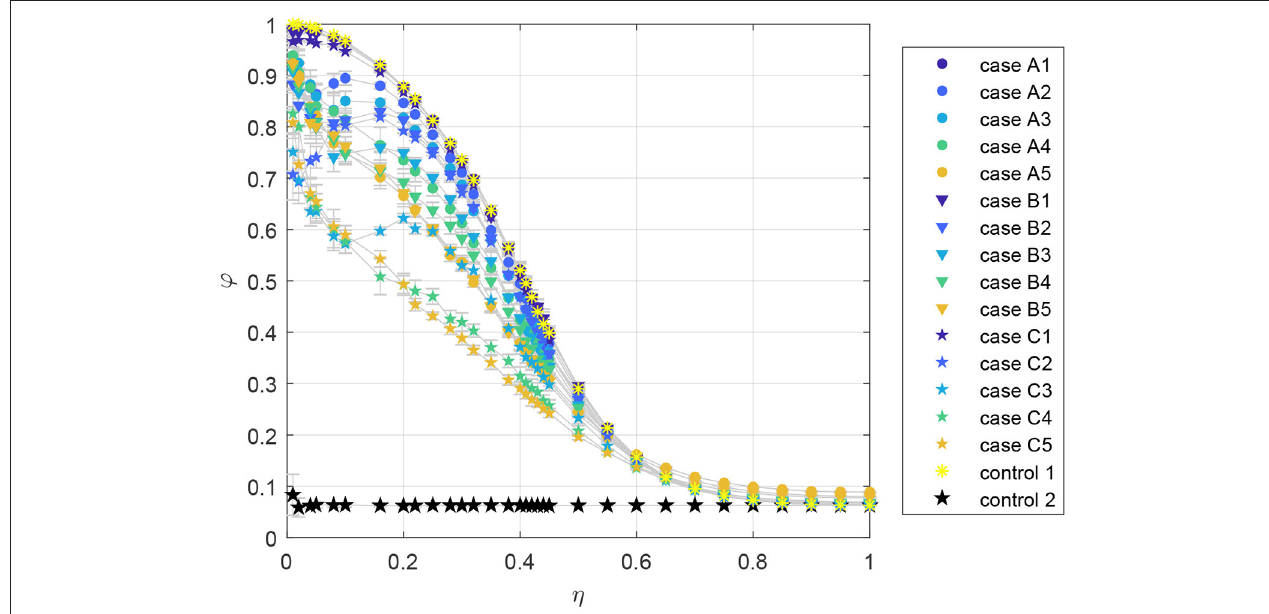
FIGURE 2 | Steady-state polarization ϕ as a function of the noise amplitude η for fifteen obstacle cases, control 1 (interaction but no obstacles), and control 2 (no interaction, no obstacles). Plots show mean values over 20 Monte Carlo replicates and the error bars in gray indicate